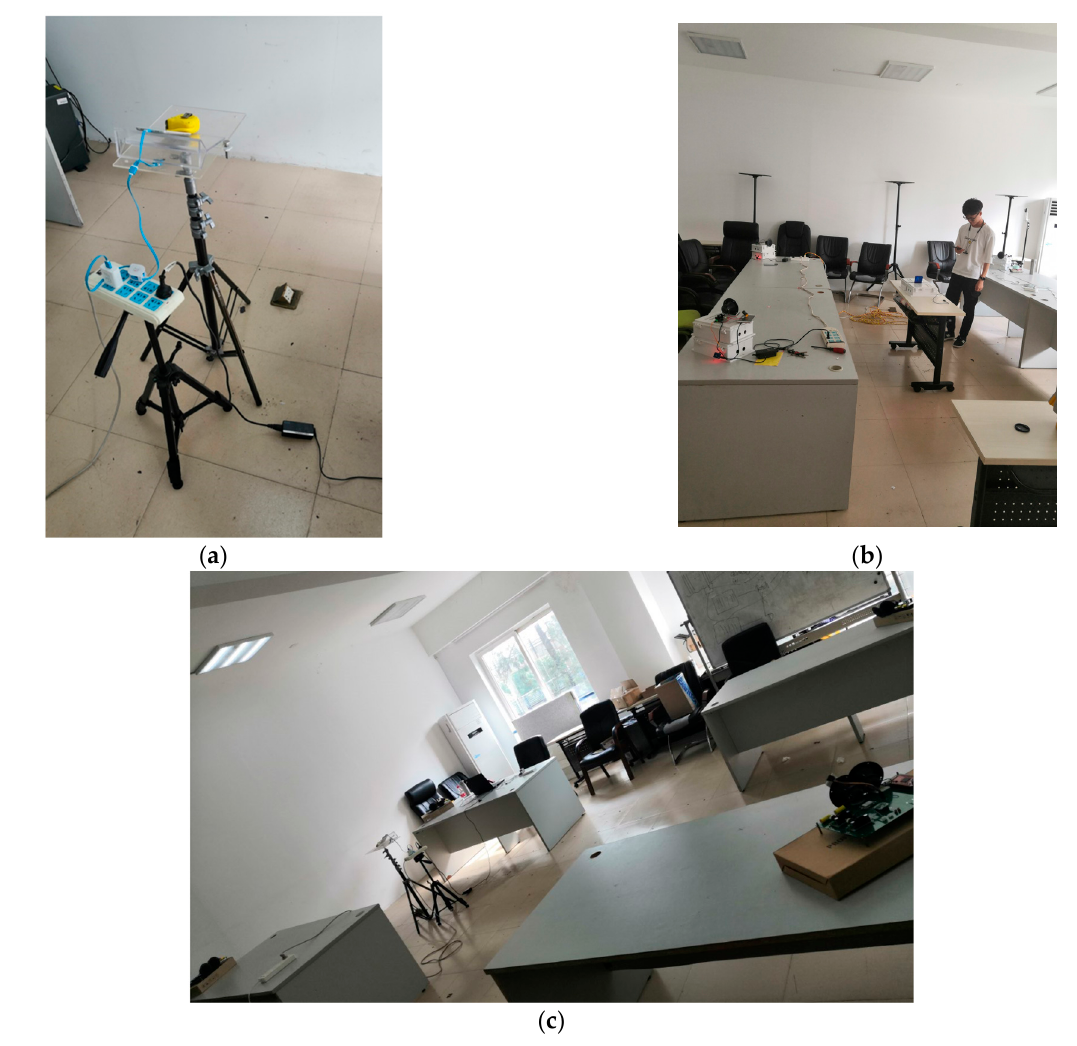
Figure 10. Experiment situations. ( a ) The reference anchor; ( b ) single receiving experiment situation; ( c ) Dual-receiving experiment situation.